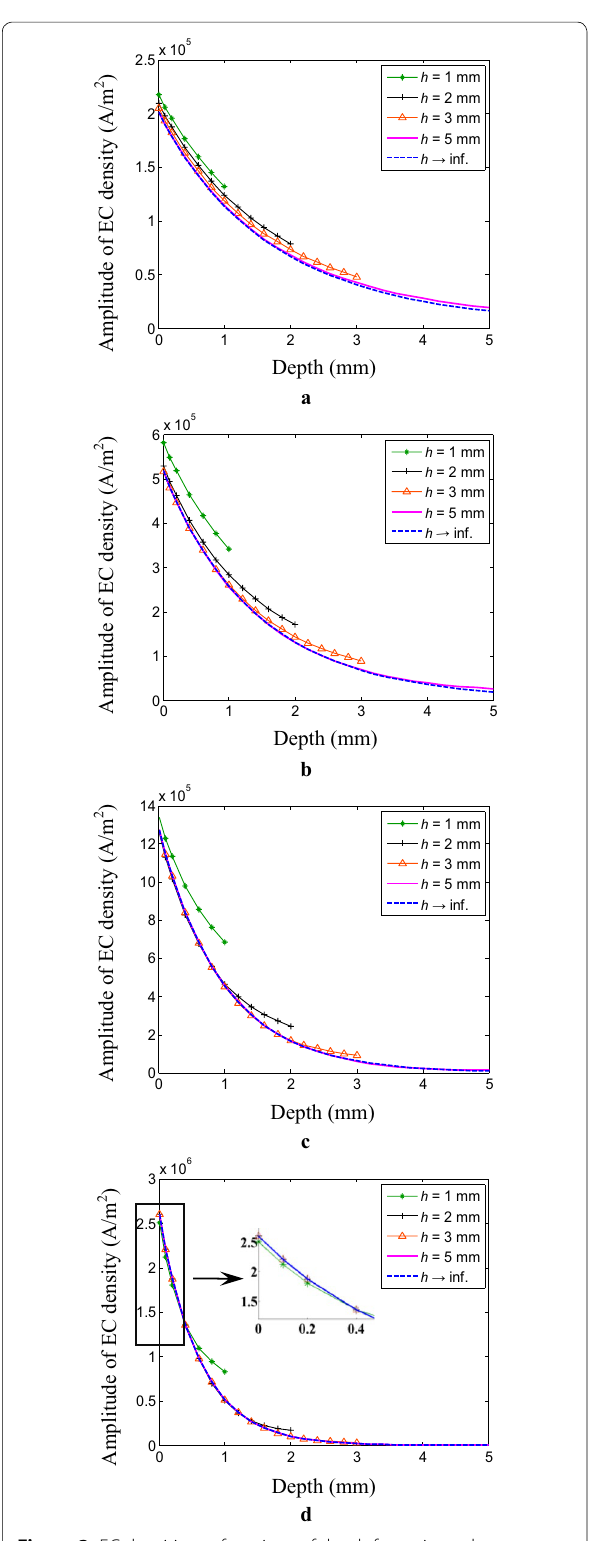
Figure 3 EC densities as functions of depth for various plate thicknesses: a 1 kHz; b 3 kHz; c 10 kHz; d 30